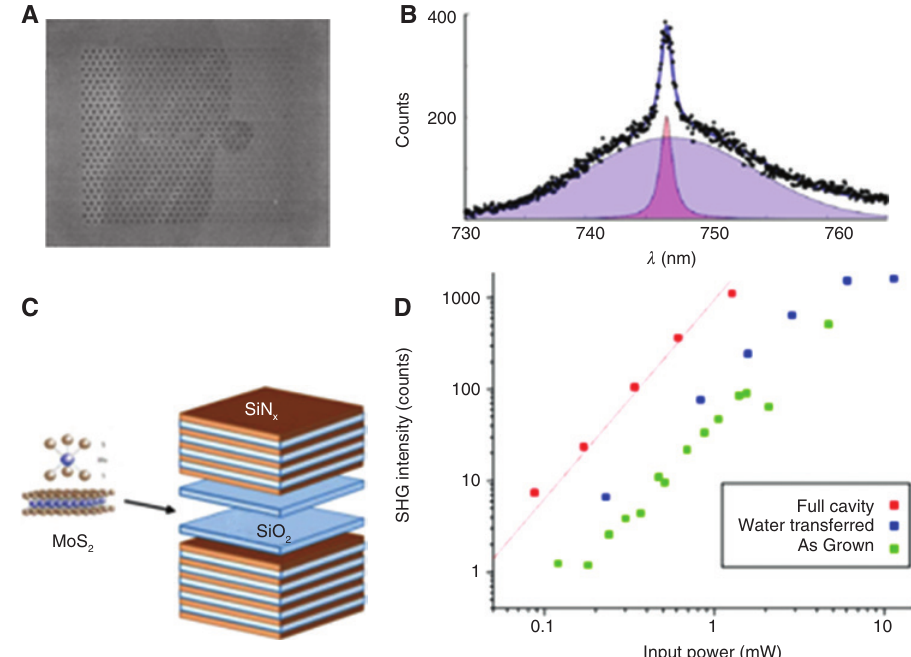
Figure 3: Cavity-enhanced second-order nonlinear optics with layered materials. (A) Scanning electron micrograph (SEM) of a WSe -clad silicon photonic crystal cavity. (B) Measured spectrum of the second harmonic signal 2 shows the Gaussian background with a Lorentzian peak signifying the cavity resonance. (C) Schematic of a distributed Bragg reflector (DBR) cavity with MoS placed in between two mirrors. The DBR is made of alternating layers of silicon dioxide and silicon nitride. (D) The meas- 2 ured intensity of the second harmonic generated light shows a clear enhancement due to the cavity. Figures (A) and (B) are reprinted from Ref. [76]; Figures (C) and (D) are reprinted from Ref.